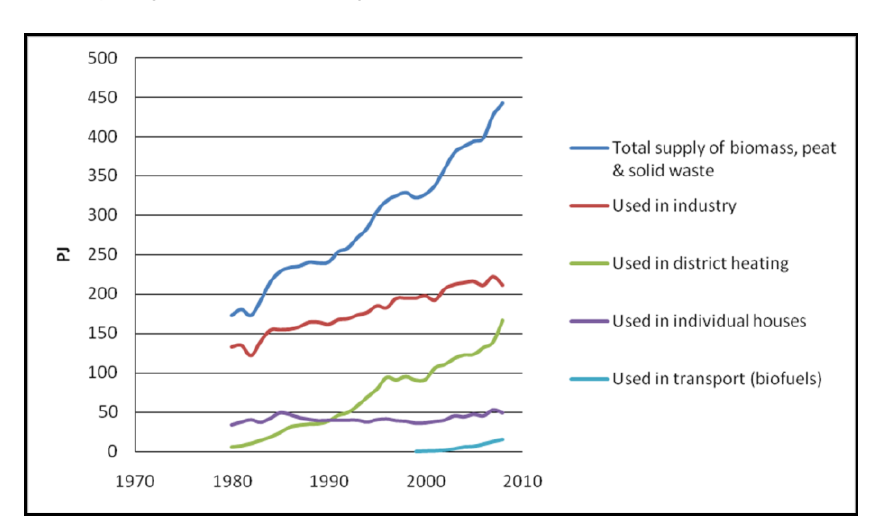
Figure 1. Total bioenergy supply (1980–2008) in Sweden (including peat and solid waste) and the amounts used in industry, district heating, individual houses, and